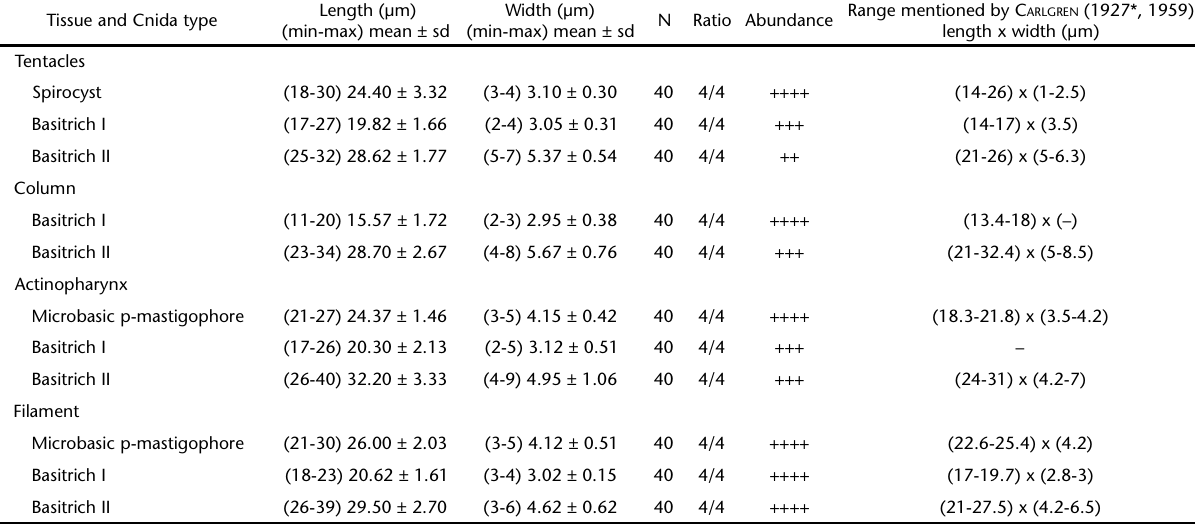
Table I. Distribution and size of cnidae of Bunodactis octoradiata . Range, length and width (sd = standard deviation). N: total number of measured cnidocysts. Ratio: proportion of number of specimens in which each cnida was found over the number of specimens examined. Abundance: (+) rare, (++++) very common. Tissue and Cnida type